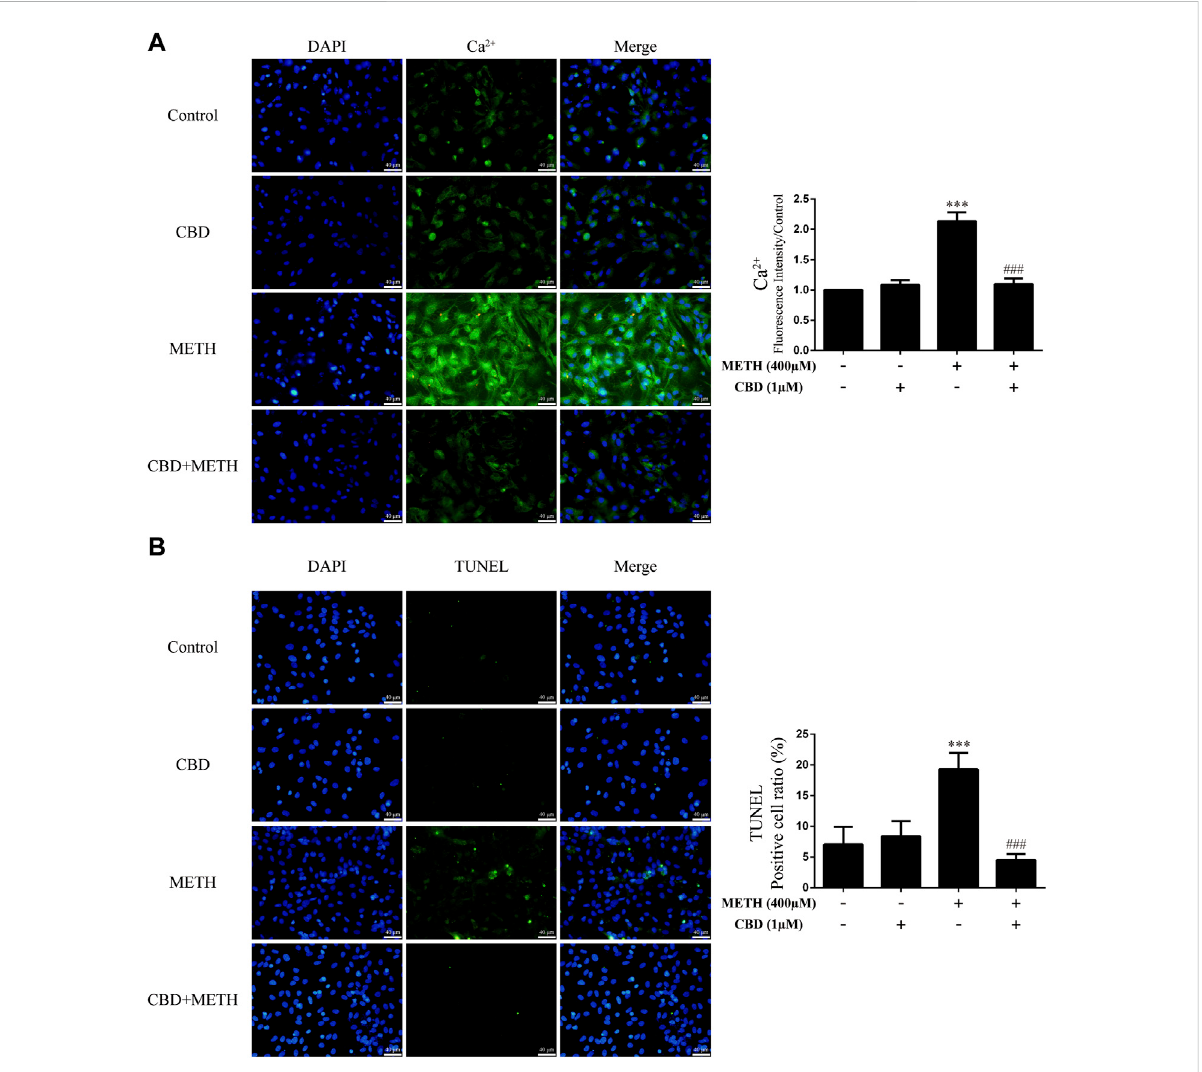
FIGURE 4 IntracellularCa 2+ andapoptosislevels inneuronsincubatedwithCBD and/orMETH. (A) Apoptosislevel inneurons. (B) IntracellularCa 2+ level